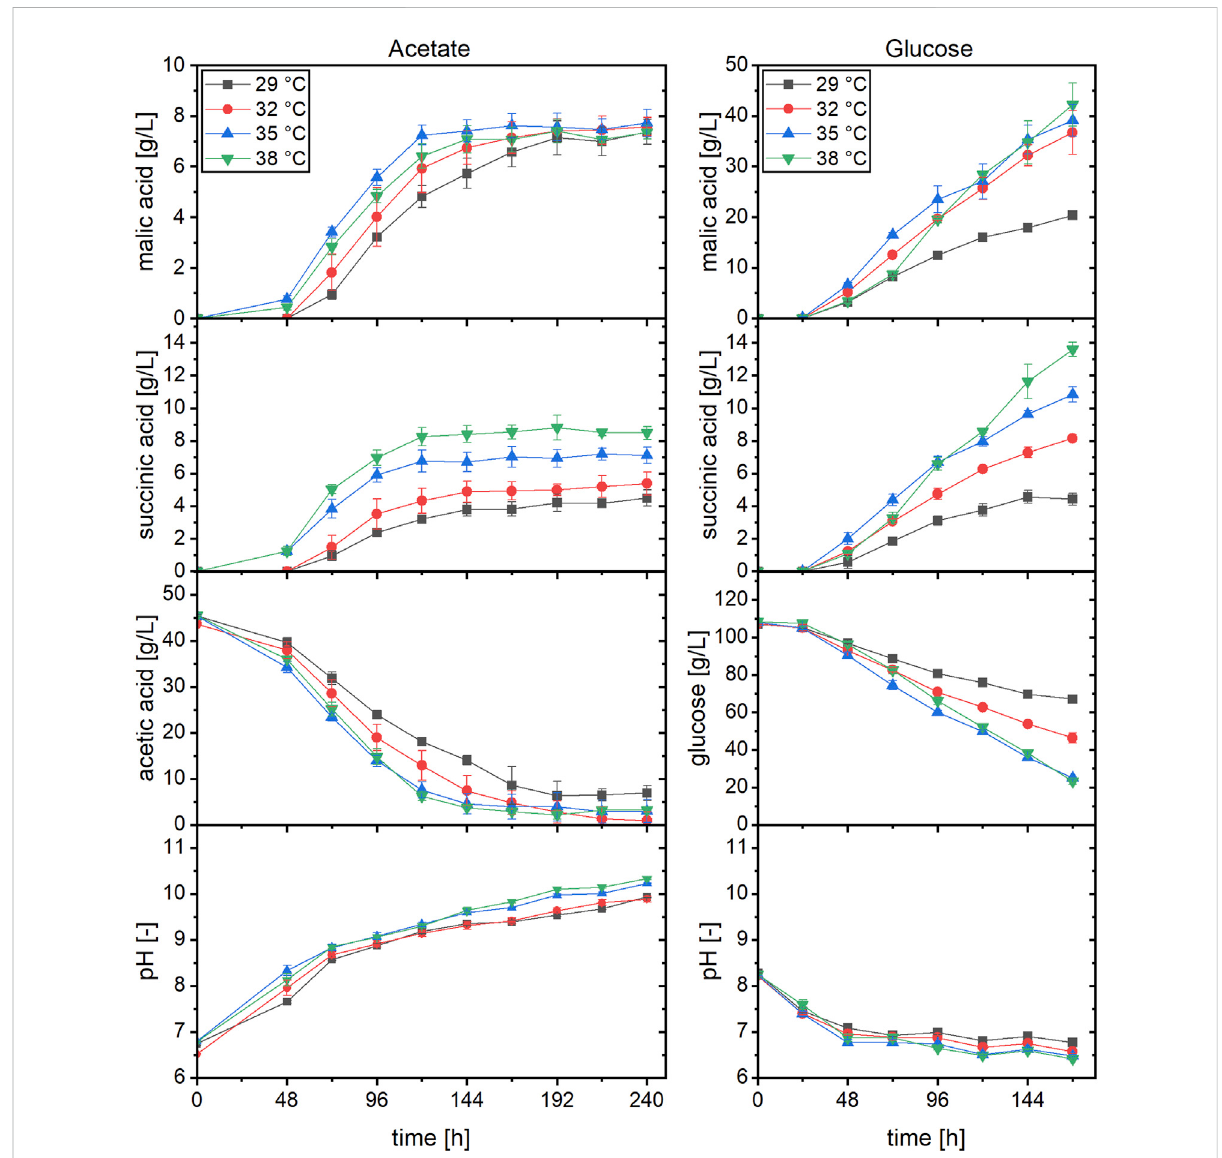
FIGURE 1 Malic and succinic acid production at different cultivation temperatures with acetate or glucose as carbon source. Datapoints represent means ± standard deviation, n =